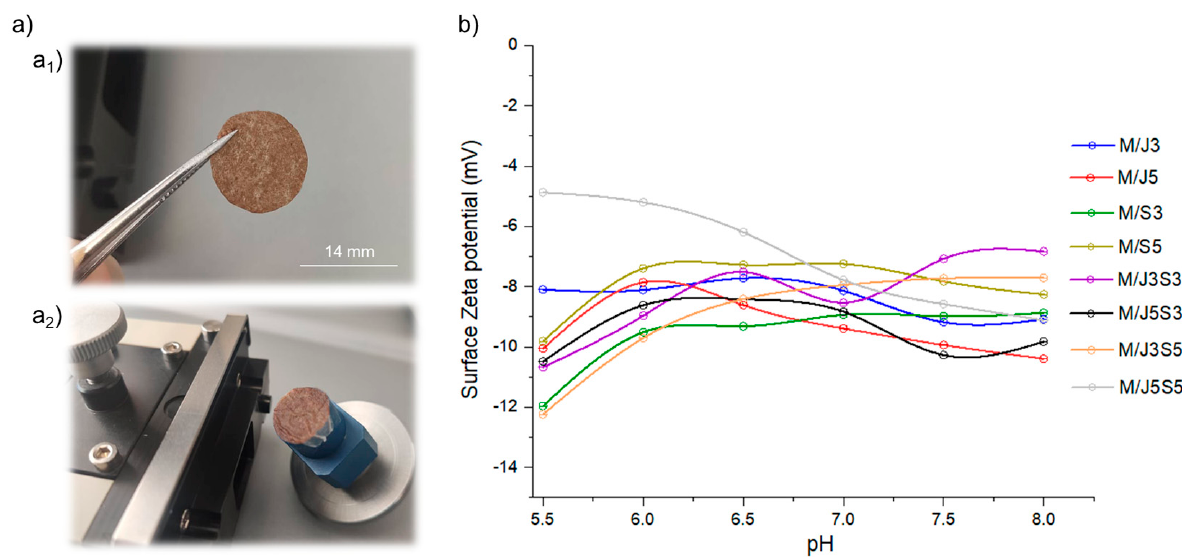
Figure 7. Surface Zeta ( ζ ) potential measurements on the membranes M/J3 to M/J5S5: ( a ) digital image of one representative membrane sample (M/J3), being glued to one surface of the surpass container, where ( a 1 ) illustrates the situation before the measurement and ( a 2 ) after used; and ( b ) titration curves of surface zeta potential within the pH range of 5.5 to 8.